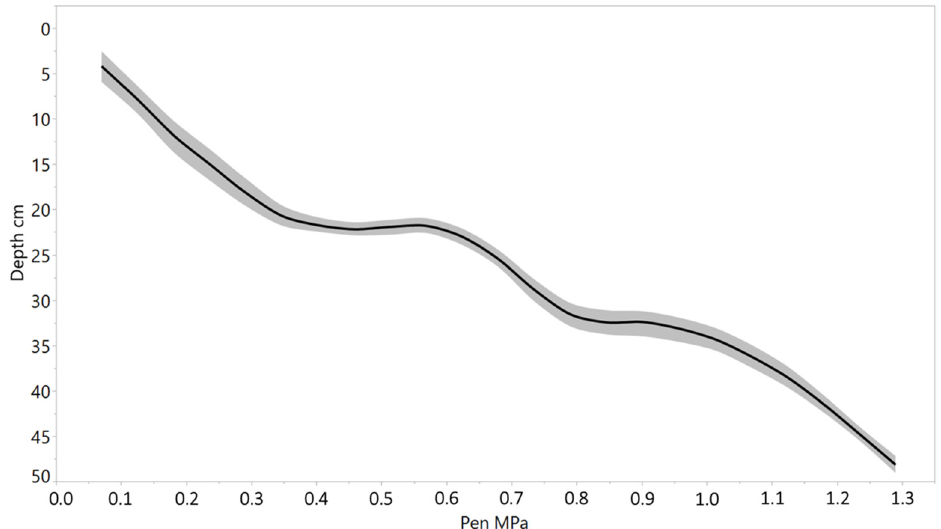
Figure 5. Penetration resistance curve in relation to depth. A cubic spline smoother with lambda = 0.05, with standardised x-values, and 95% confidence interval.